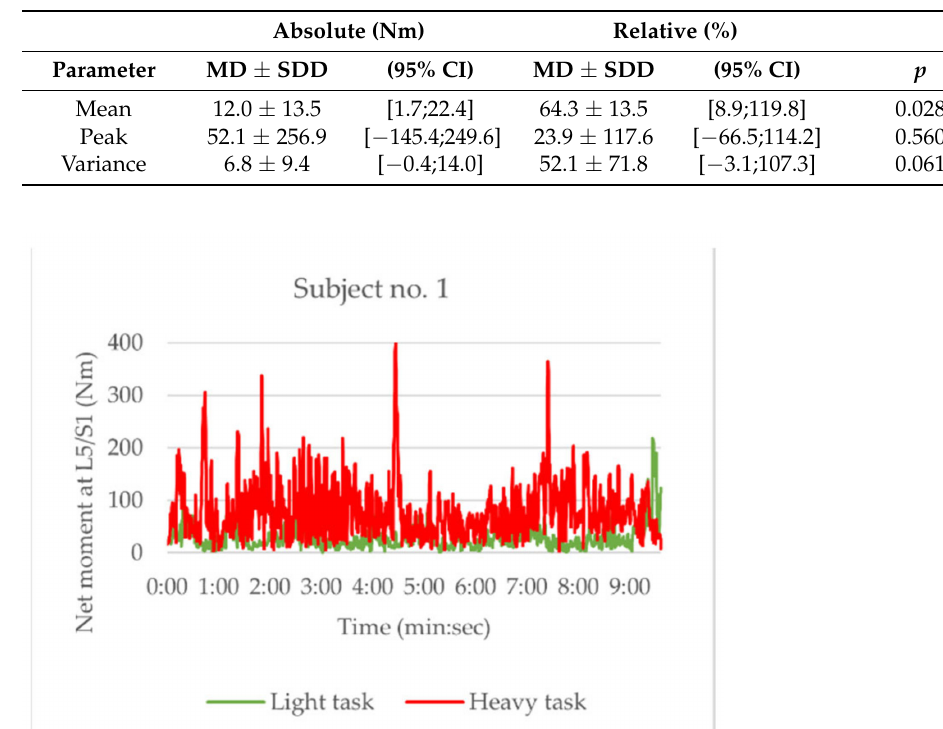
Table 6. Light vs. heavy tasks. Shown are the absolute (Nm) and relative (%) differences between the light tasks and the heavy tasks through mean difference (MD: heavy–light task) and its standard deviation (SDD) plus 95% confidence interval (CI) of these differences for the moment magnitude (||M||) with p -value of paired t -test.